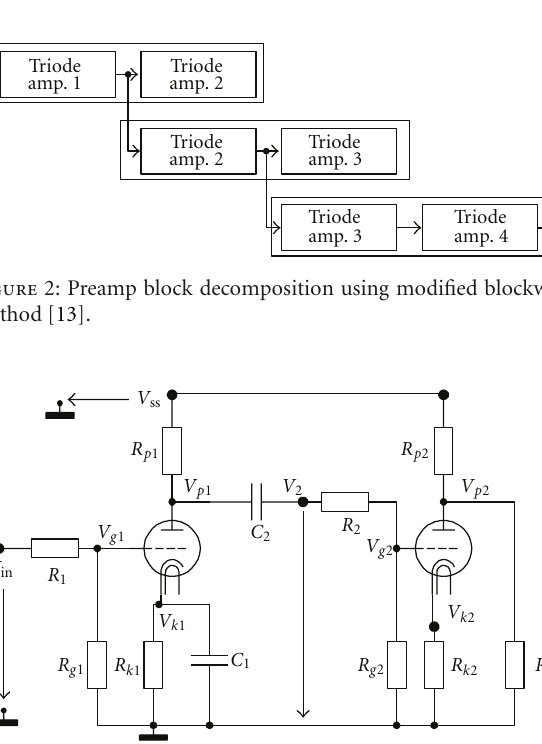
Figure 3: Circuit schematic of the first block of the guitar